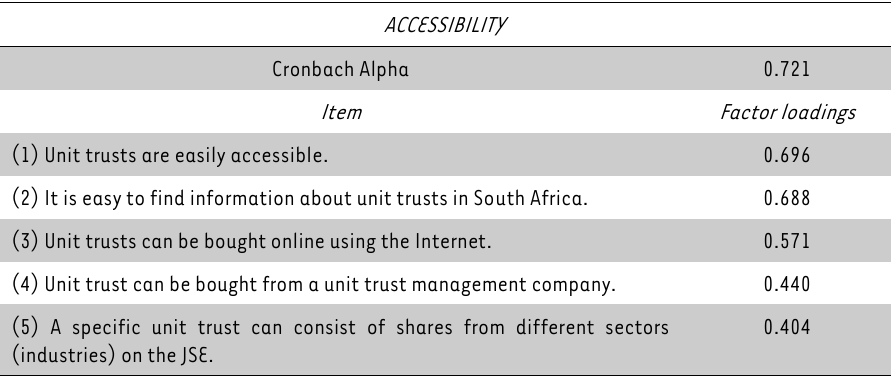
TABLE 2: Factor 2 - Accessibility